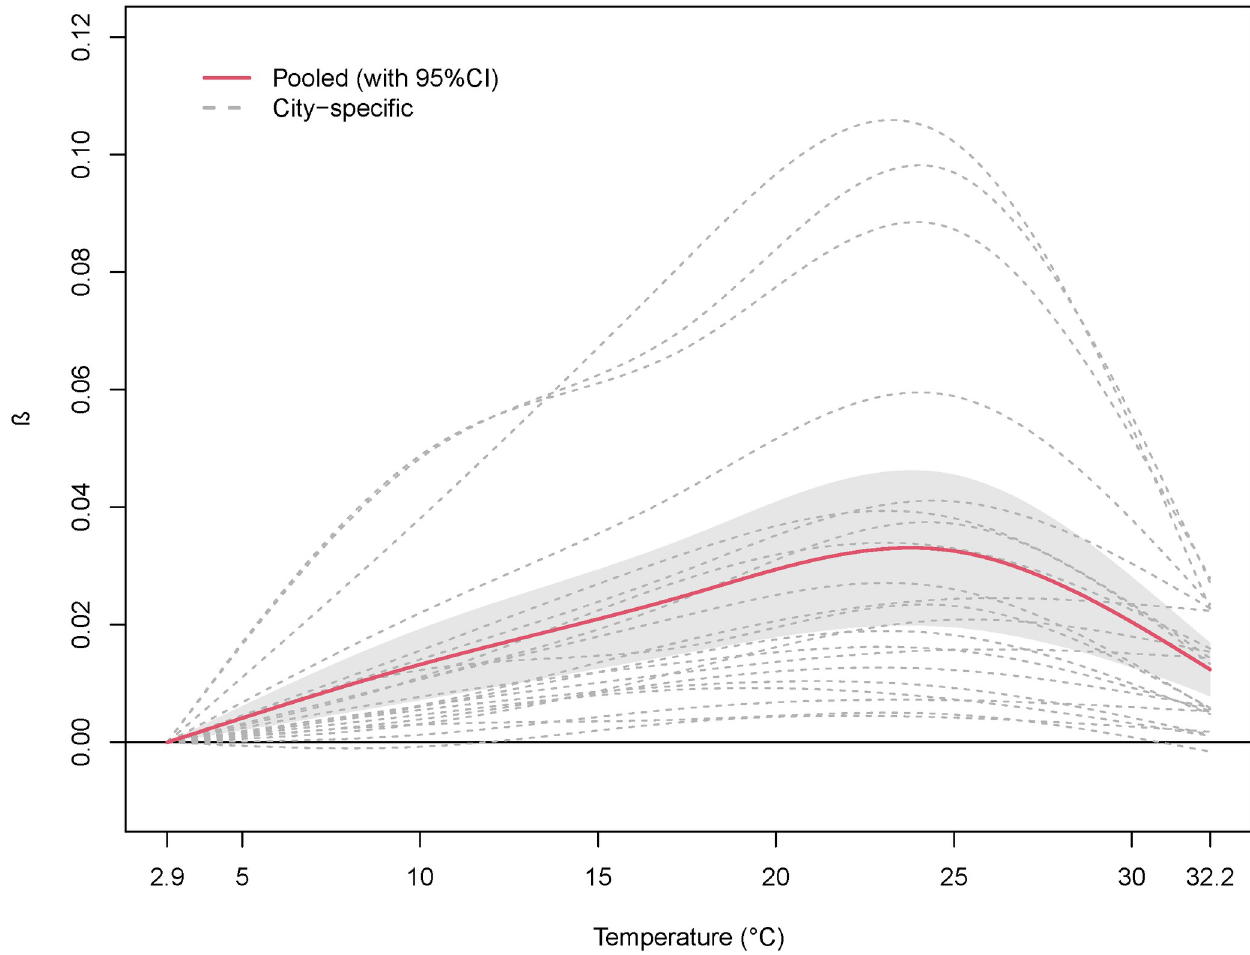
Fig 2. Overall cumulative predicted association of HFMD DALY associated with daily average temperature. HFMD: Hand, foot, and mouth disease; DALY: Disability-adjusted life year; Pooled: The results pooled the 21 city-specific results; β was the regression coefficient of temperature; The association was predicted on lag 0–14 days and reference temperature was